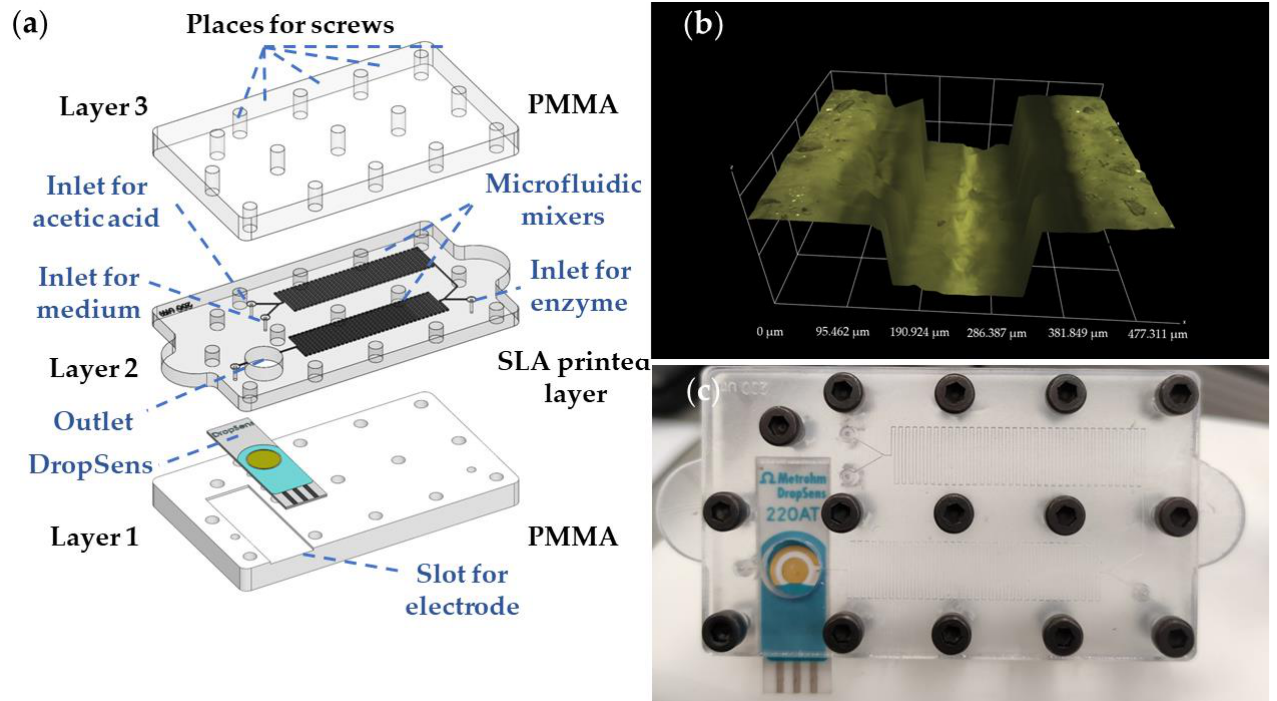
Figure 3. ( a ) Multilayer structure of the proposed LOC. ( b ) Three-dimensional profile of the SLA printed MF channel. ( c ) Realized LOC with integrated DropSens sensor. printed MF channel. ( c ) Realized LOC with integrated DropSens